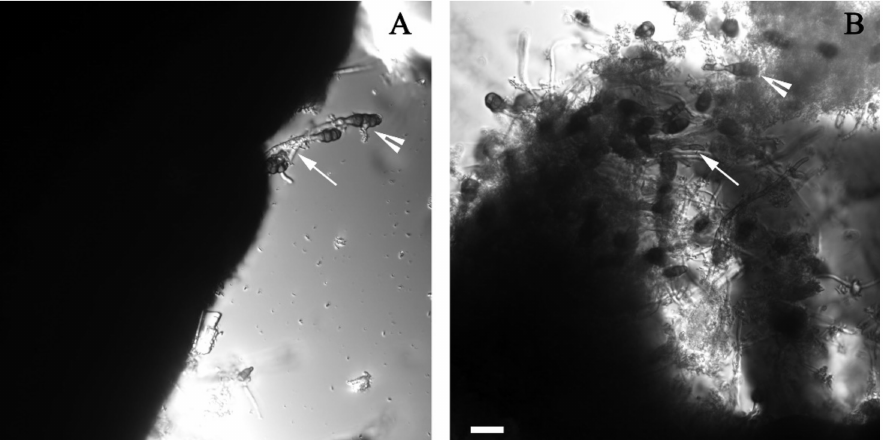
Figure 5. Differential interference contrast microscopy of Alternaria sp. grown in Czapek minimal medium containing 0.5% w/v of extra-heavy crude oil (7–10 ◦ API). ( A ) Hyphae (arrow) and septate conidia (arrowhead) emerging from a dense mass of petroleum. ( B ) Mycelium (arrow) and conidia (arrowhead) with Czapek minimal medium salts and petroleum. Scale bar = 25 µ m.